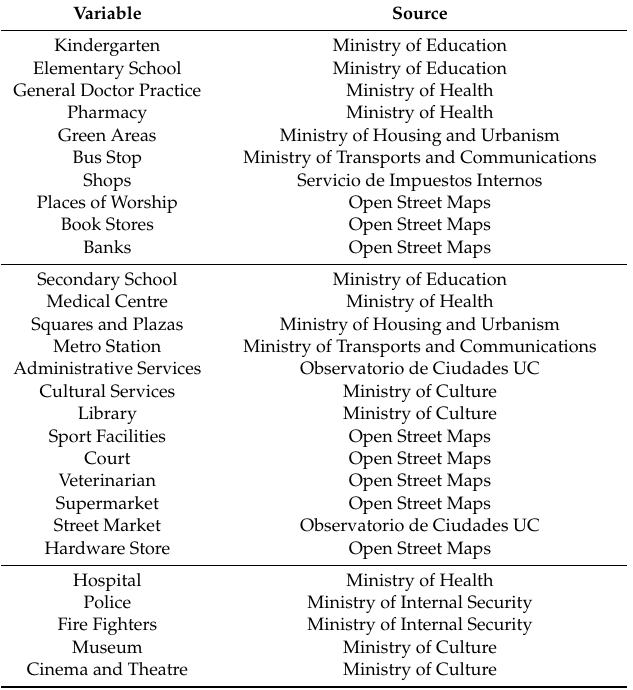
Table 1. Essential urban functions included in the study in hierarchical order. Source: authors based on public information available from Government Sources, Servicio de Impuestos Internos, Observatorio de Ciudades UC and Open Street